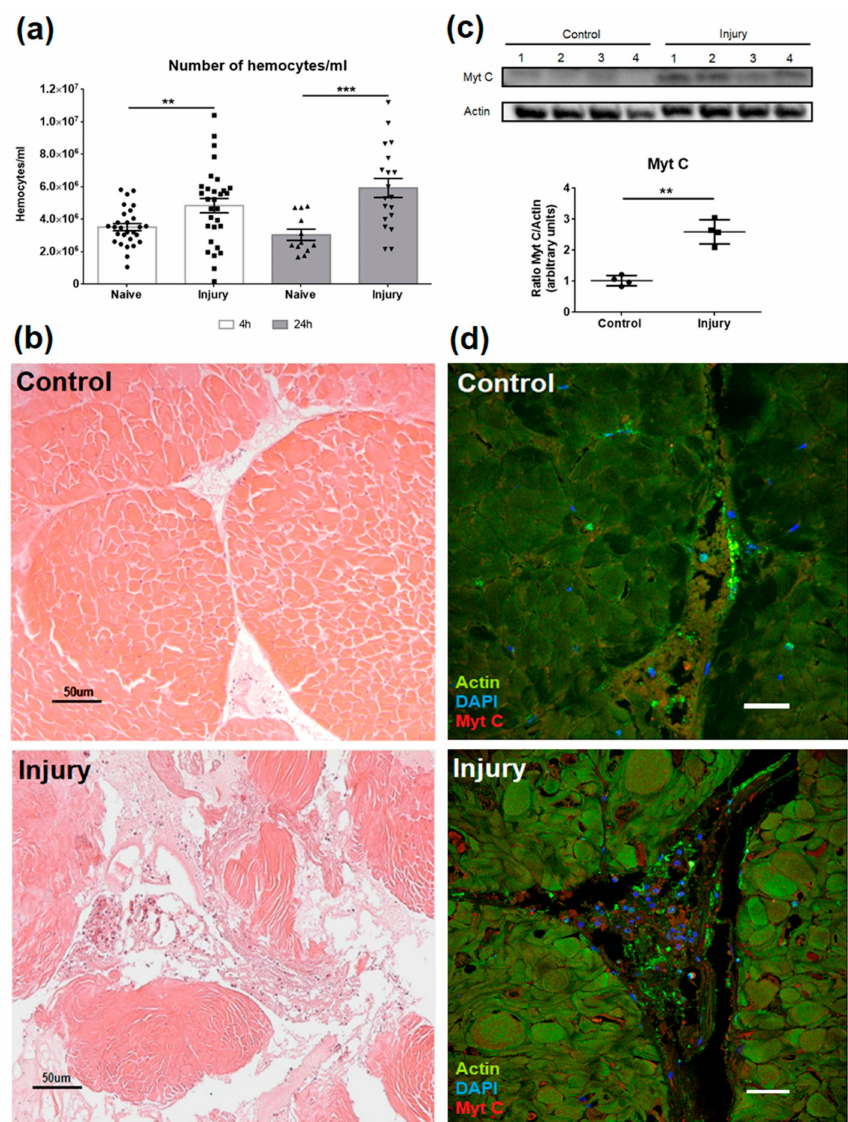
Figure 5. ( a ) Number of hemocytes in mussel muscle 4 h and 24 h after an injury. Asterisks indicate significant di ff erences at p < 0.01 (**) and p < 0.001 (***). ( b ) Histological sections of healthy or injured adductor muscle using hematoxylin and eosin (HE) staining. Note the increase in the number of hemocytes in the damaged area. ( c ) Western blot of myticin C in samples of hemocytes extracted from naïve and injured mussels. Asterisks indicates significant di ff erences at p < 0.01 (**). ( d ) Immunofluorescence of muscle sections of healthy or injured muscles. Triple labeling of actin (green), myticin C (red), and 4 (cid:48) ,6-diamidino-2-phenylindole (DAPI) (blue). Bar scale represents 25 µ